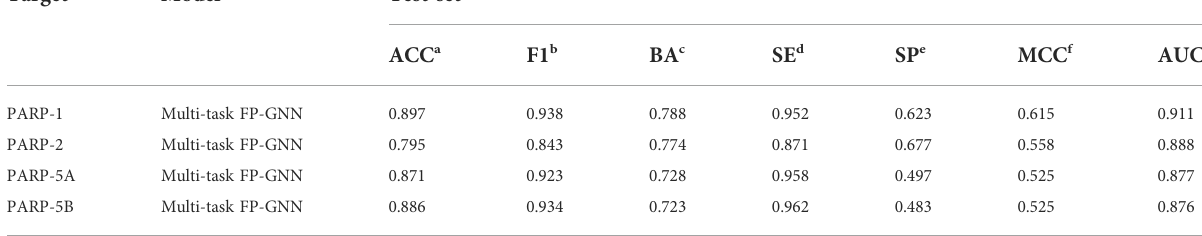
TABLE 5 The detailed performance of the multi-task FP-GNN model for each PARP